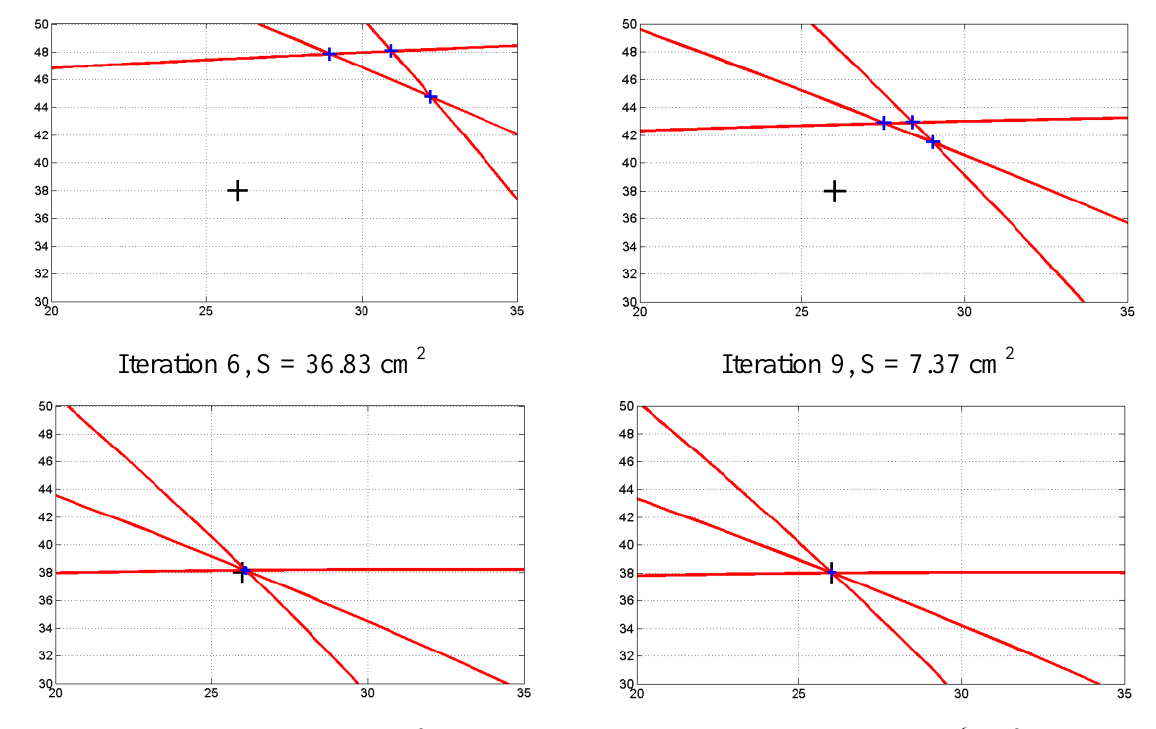
Figure 8. Sequence of intersection points for 6, 9, 20 and 32